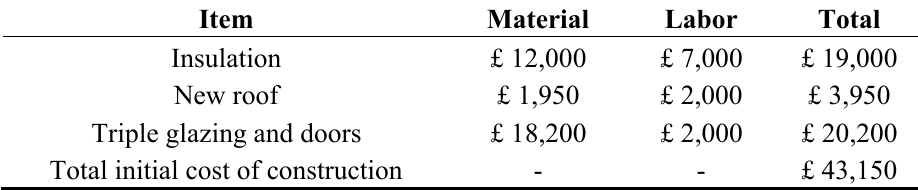
Table 5. Cost breakdown for the terraced house’s